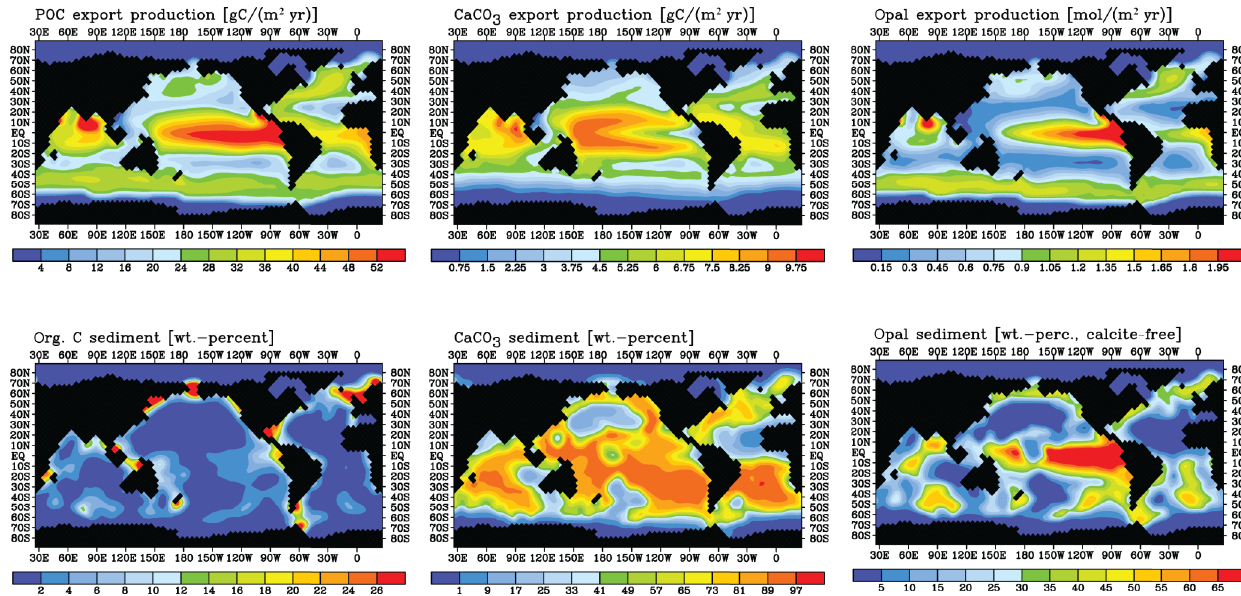
Figure 1. Export production rates and average surface sediment distributions for the control run.